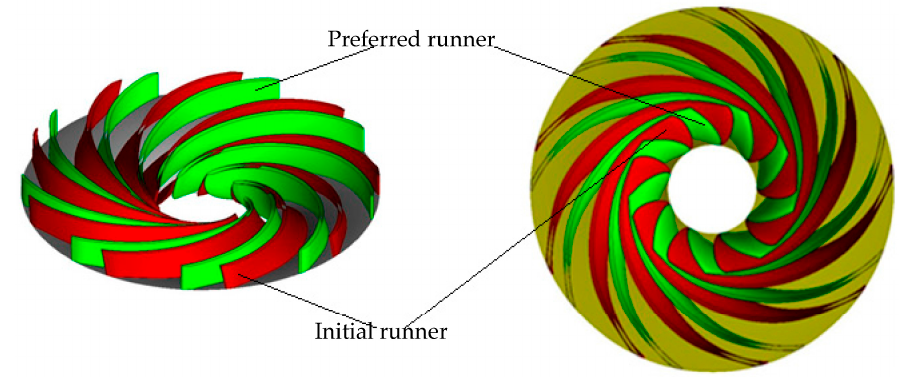
Figure 8. Comparison of the blades for two runners.